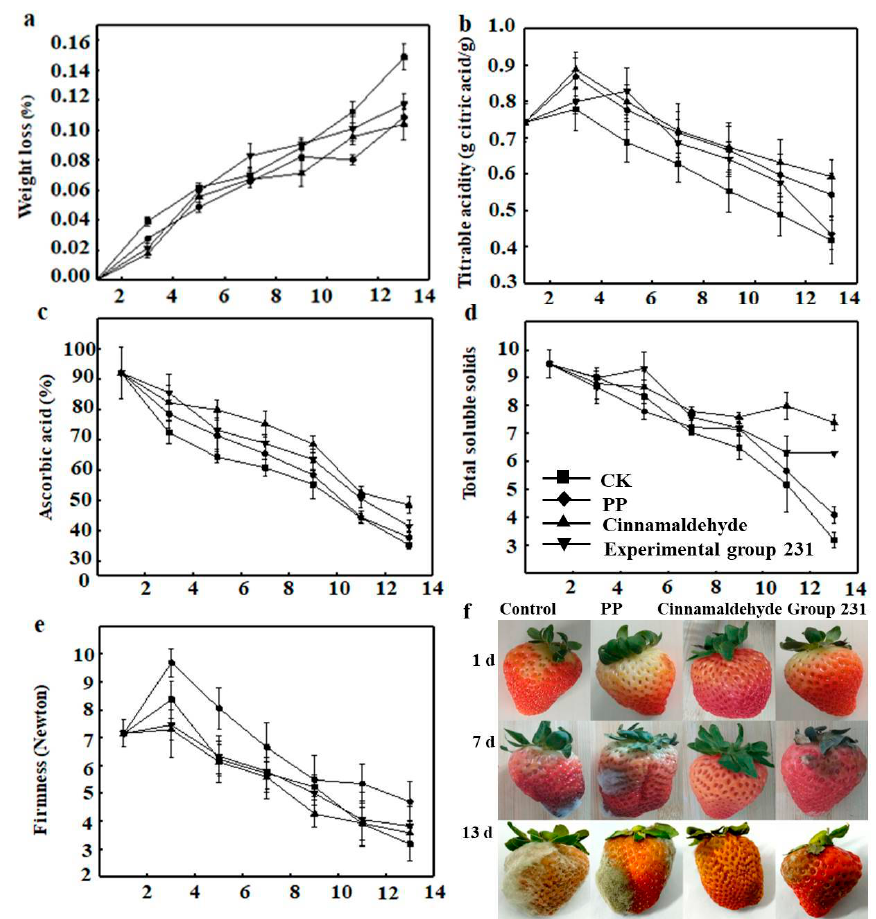
Figure 5. The effects of different films on ( a ) weight loss, ( b ) titratable acidity, ( c ) ascorbic acid content, ( d ) total soluble solids, ( e ) firmness of strawberries stored at room temperature, and ( f ) the visual appearance of packaged strawberries after 13 days storage at room temperature ( p < 0.05).